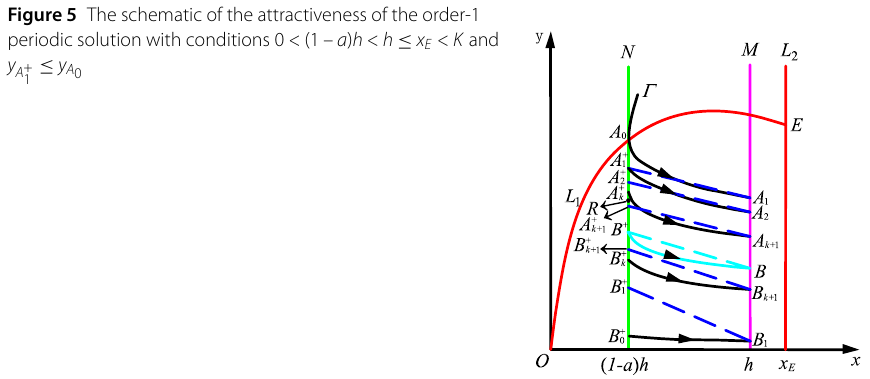
Figure 5 The schematic of the attractiveness of the order-1 periodic solution with conditions 0 < (1 – a ) h < h ≤ x E < K and ≤ y y A A + 1